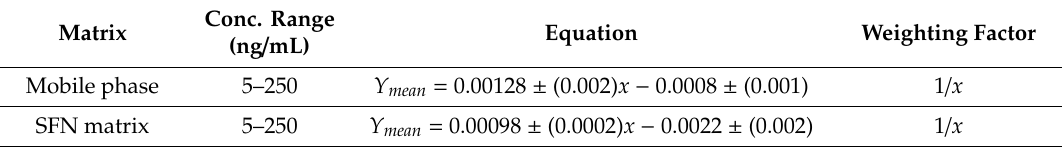
Table 1. Calibration curve characteristics for quantifying PTX in SFNs-PTX. Conc. Matrix